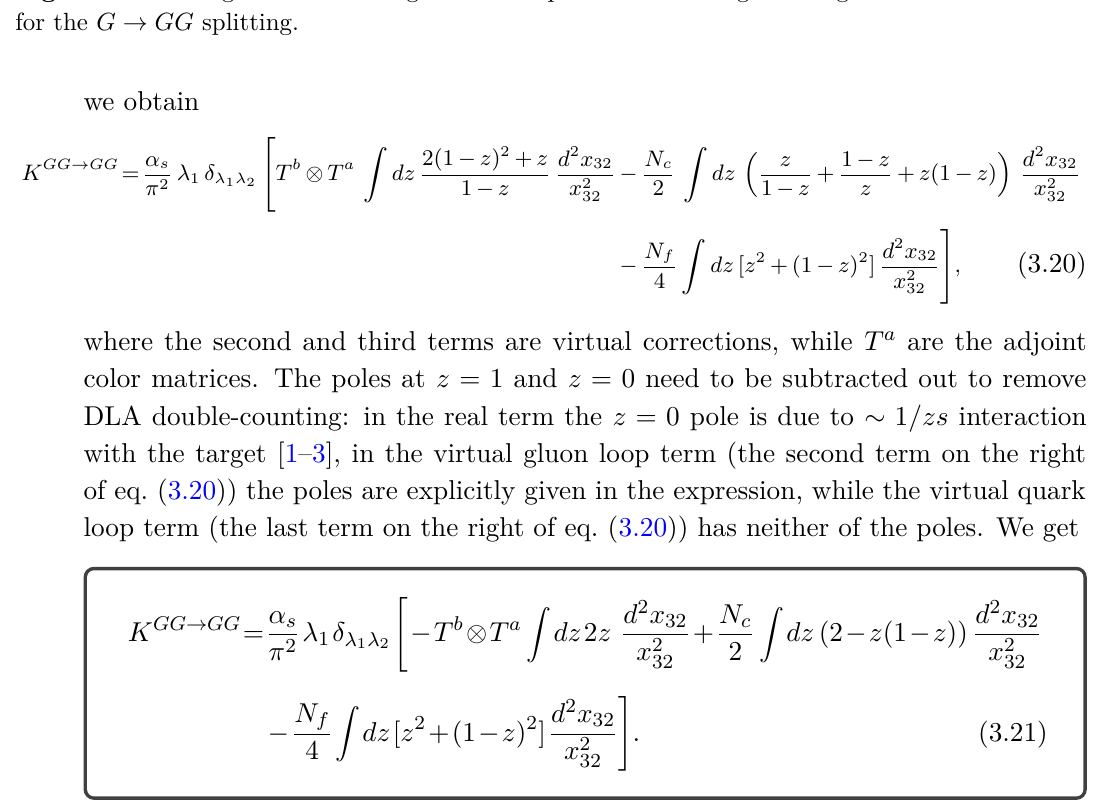
Figure 3 . The diagram contributing to the real part of the leading-order light-cone wave function for the G → GG